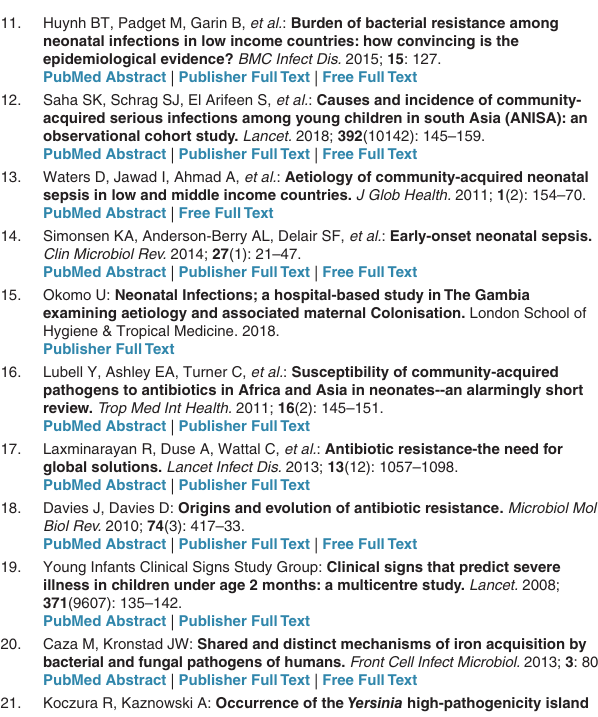
Figshare: Cross et al. GatesOpen Research SCC1525v2__NeoIn- nate_Participant Info&Consent form Route 1. https://doi.